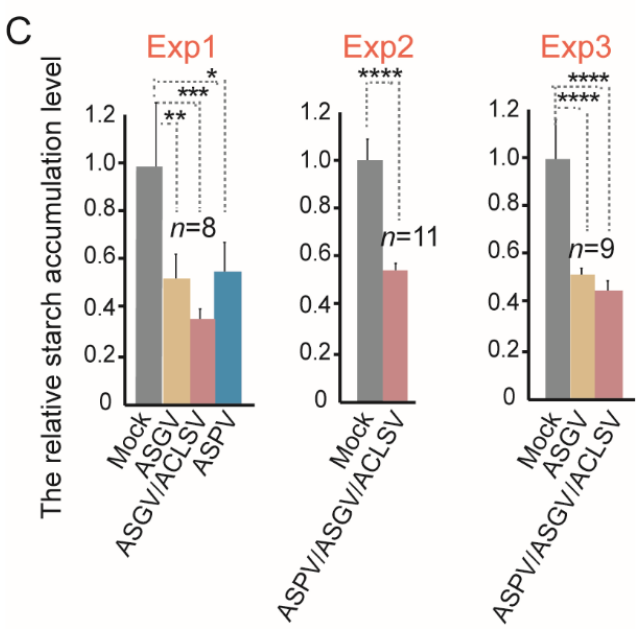
Figure 3. Detection of latent viruses in the propagated tissue cultures by assessing the starch content. ( A ) Shoots of apple ( Malus domestica ) propagated by tissue culture (5 weeks old). Shoots with virus infection are indicated. ( B ) RT-PCR detection of viruses in the apple shoots described in ( A ) using primer sets specific for the viral coat protein gene. Amplification of Malus EF-a was used as a control standard. ( C ) Relative starch accumulation in the virus-infected apple shoots described in (I). Data are presented as mean ± SD. The mock sample data value was set to 1.0. “*, **, ***”, and “****” indicate a significant difference at p < 0.05, 0.01, 0.001, or 0.0001, respectively (Student’s t -test).